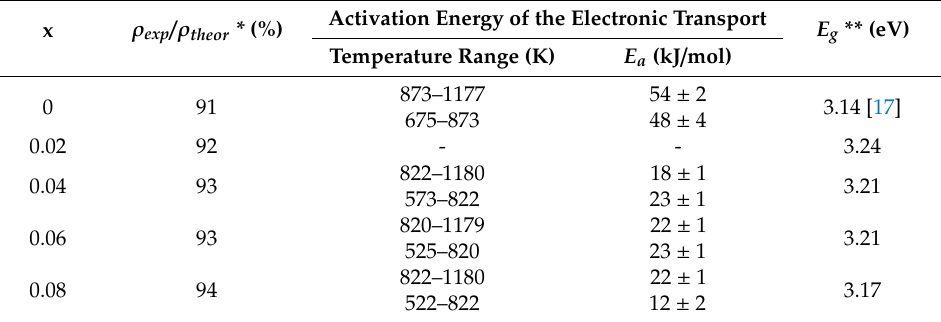
Table 1. Selected properties of the samples with nominal composition Zn 1 − x Ta x O.